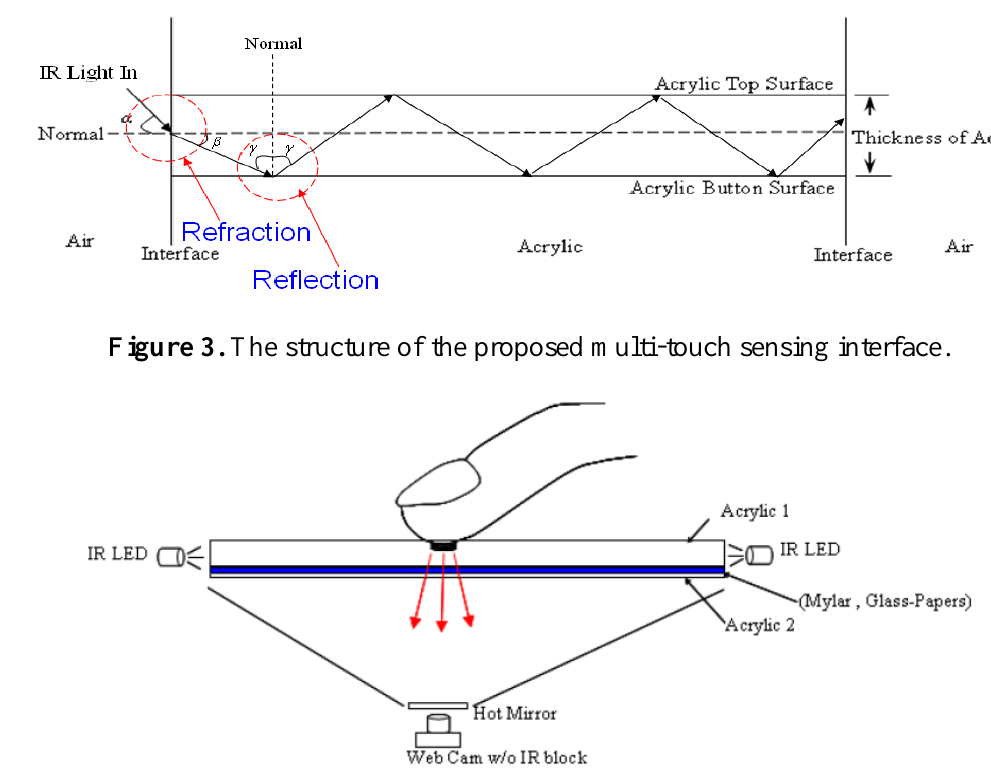
Figure 2. Total internal reflection in an acrylic board.